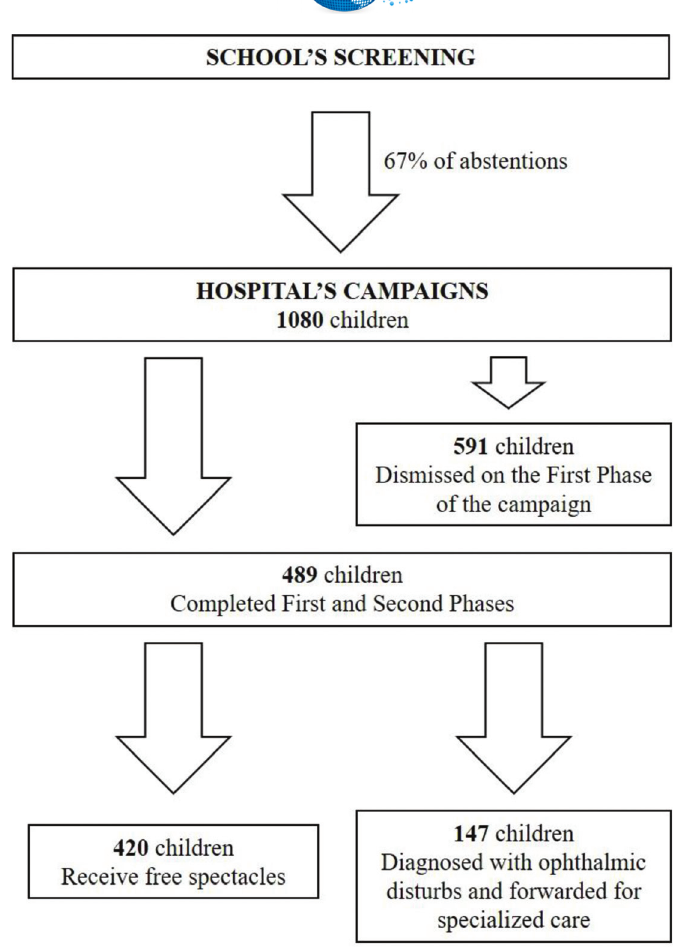
Figure 2 - ‘‘ Vision for the Future ’’ children ’ s participation flowchart for the year